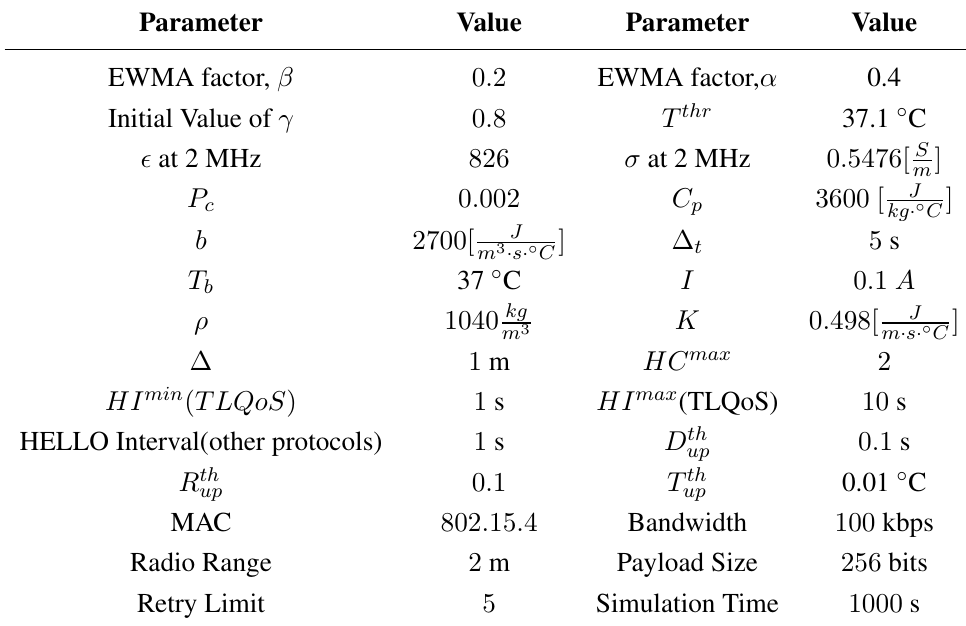
Table 1. Simulation